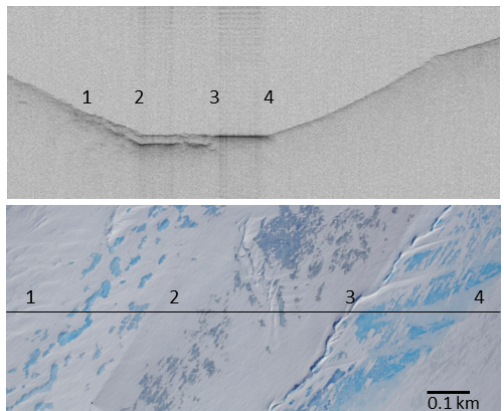
Figure 6. Snow Radar echogram (top) with DMS image of GrIS snow surface (bottom) taken on 2 May 2011 for a buried lake in northern Greenland ( ∼ 100km inland from the terminus of 79N Glacier) showing from location 1 to 2 the turquoise blue re- frozen lake, from 2 to 3 the darker blue retained water, a pressure ridge at 3, and from 3 to 4 surface melt caused by radiative heating at the surface of the refrozen lake